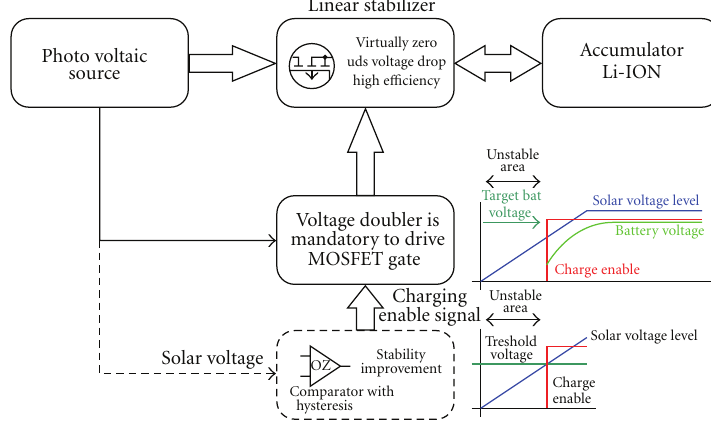
Figure 5: The block diagram of the charging circuit with a solution of stability.